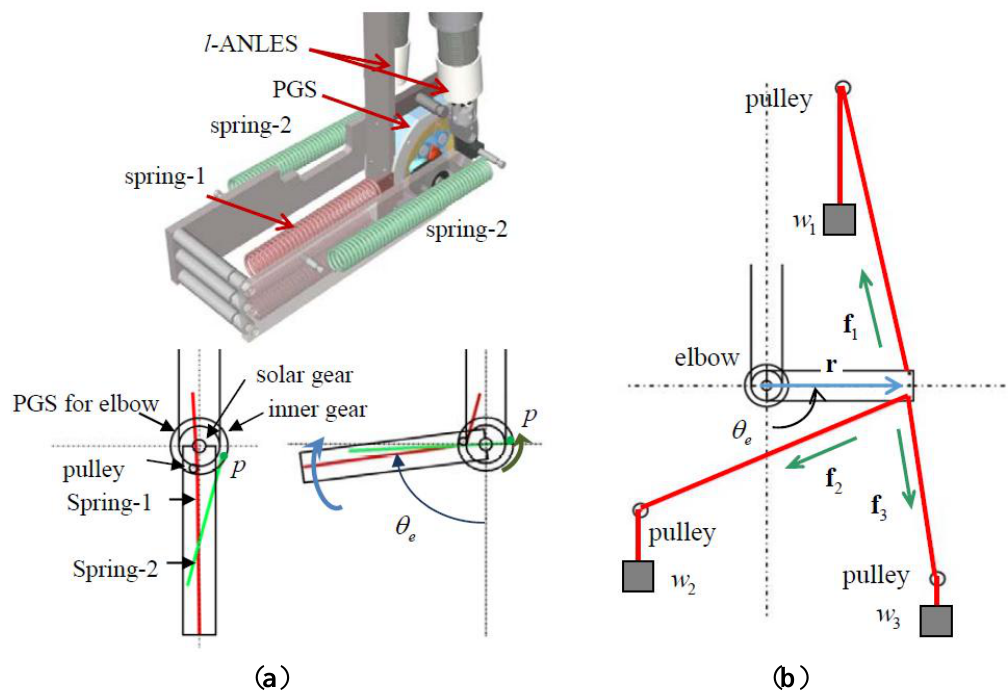
Figure 9. ( a ) Placement of the weight compensation springs. ( b ) Experimental apparatus for the weight compensator.